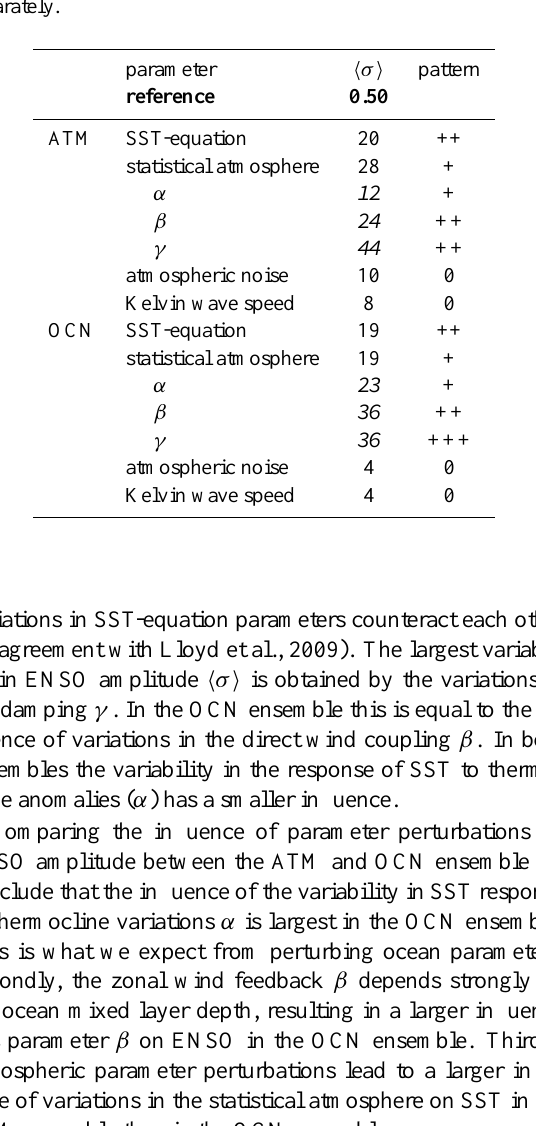
Table 3. Influence of different components in the feedback loop on ENSO amplitude and pattern in the ICM when varying the parame- ters in different ICM components based on the values fitted from the GCM experiments. Values are calculated as the spread in the ampli- tude, expressed as a percentage change from the STAM-member ac- complished by varying one of the components in the feedback loop separately. Absolute values for the amplitude h σ i for the STAM member are given in the top row. For the pattern, we qualitatively assess the influence of the components as ranged from very little influence (0) to largest influence (++). Absolute values for the am- plitude h σ i in the east Pacific (Table 1) for the STAM member are given in the top row. For the SST-equation parameters a the total contribution is listed as well as the influence of the three parameters